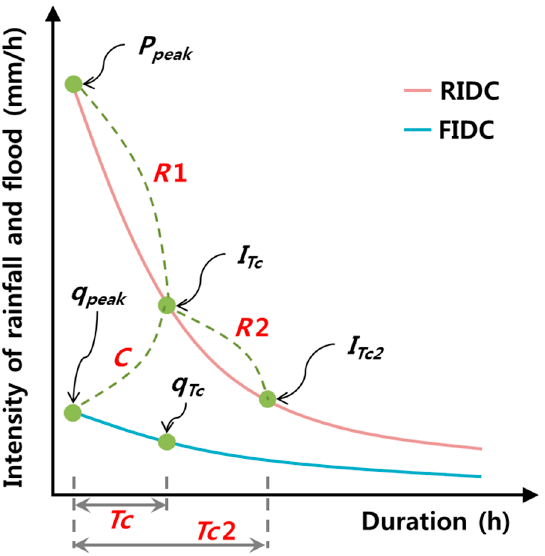
Figure 3. Schematic plot for the calculation of the runoff coefficient ( C ) and rainfall intensity ratios ( R 1 and R 2); T c is the time of the concentration in hour; T c 2 is TC multiplied by two; C is the ratio between the flood peak ( q peak ) and the mean rainfall intensity during TC ( I Tc ); R 1 is the ratio between the rainfall peak ( P peak ) and I Tc ; and R 2 is the ratio between I Tc and the mean rainfall intensity during two TCs ( I Tc 2 ). FIDC and RIDC are flood-intensity-duration curve and rainfall-intensity-duration,